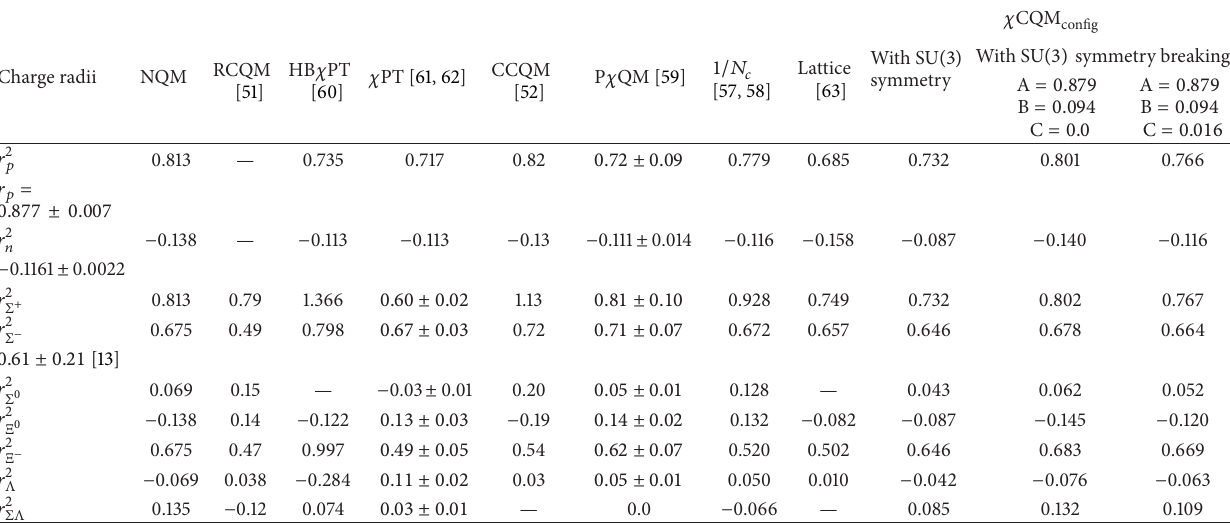
Table 5: Charge radii of octet baryons calculated in 𝜒 CQM in comparison with other phenomenological models (in units of fm 2 ).